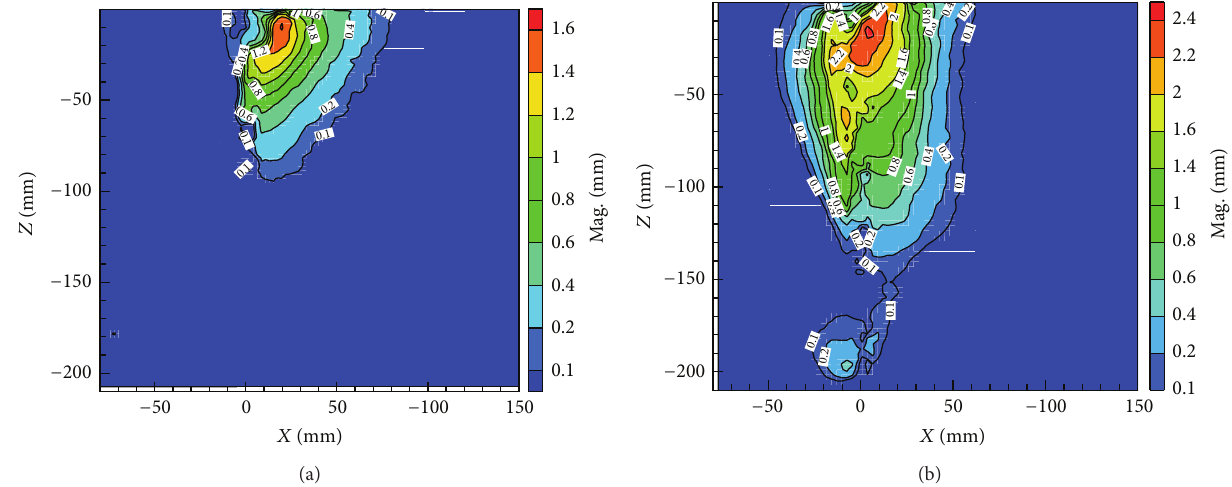
Figure 7: Contours of displacement fields at the vertical profile: (a) contours of displacement field in dense sand; (b) contours of displacement field in loose